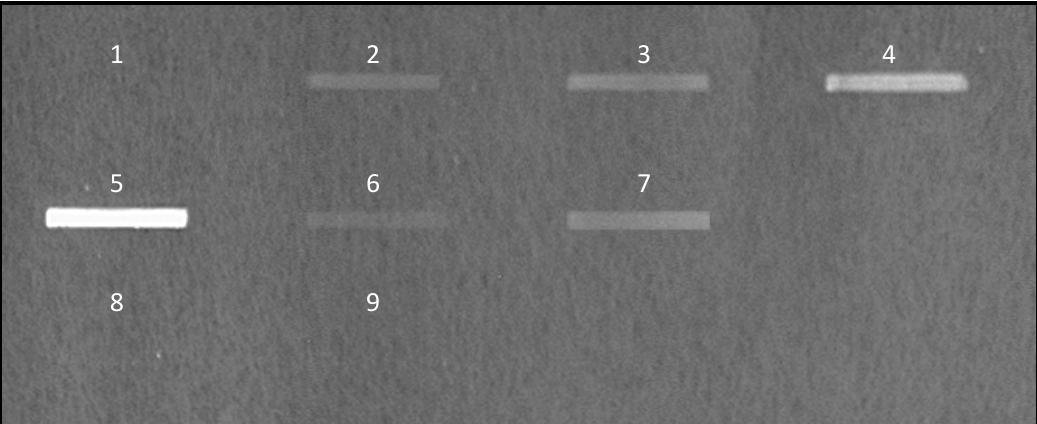
Figure 1. Adhesion of DAPI-labeled L. paracasei on mucins. Purified mucins were spotted on nitrocellulose membrane before incubation with DAPI-labeled bacteria. Fluorescence signaling was detected using the Chemigenius2 Bio-imaging system before quantification with GeneTools software. Spotted samples were BSA (1); pig gastric mucin (2); and human mucins purified from ileum (3); jejunum (4); colon (5); stomach (7) and ovarian cysts (8). After chemical removal of sialic acids, mucins from human colon and ovarian cysts were spotted respectively at positions (6) and